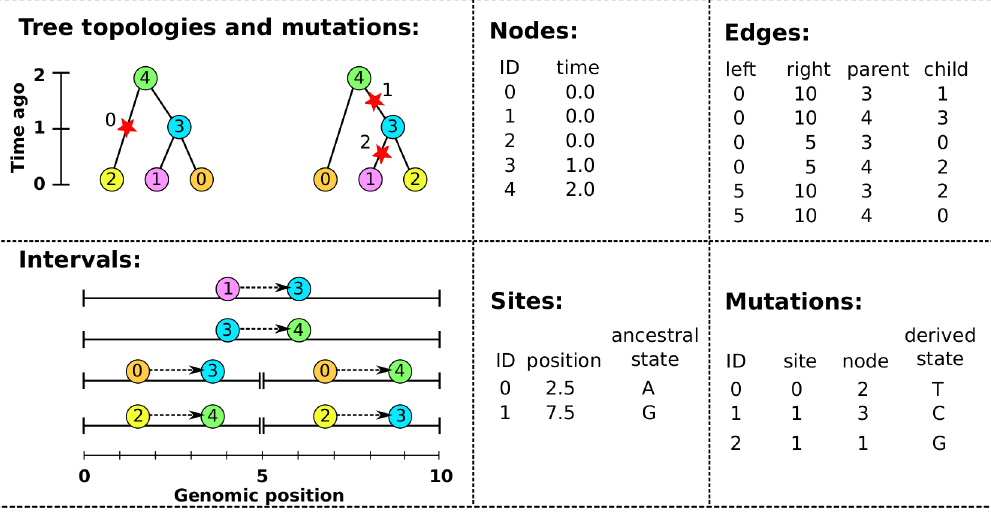
Fig 3. An example tree sequence with three samples over a chromosome of length 10. The leftmost panels show the tree sequence pictorially in two different ways: (top) a sequence of tree topologies; the first tree extends from genomic position 0 to 5, and the second from 5 to 10; and (bottom) the edges that define these topologies, displayed over their corresponding genomic segment (for instance, the edge from node 2 to node 4 is present only on the interval from 0 to 5). The remaining panels show the specific encoding of this tree sequence in the four tables (nodes, edges, sites and